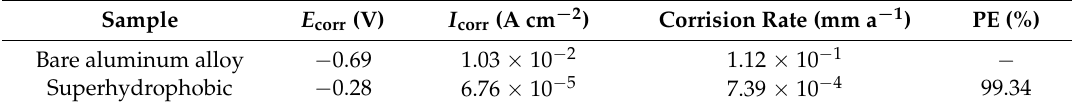
Table 2. Electrochemical parameters of potentiodynamic polarization curves.